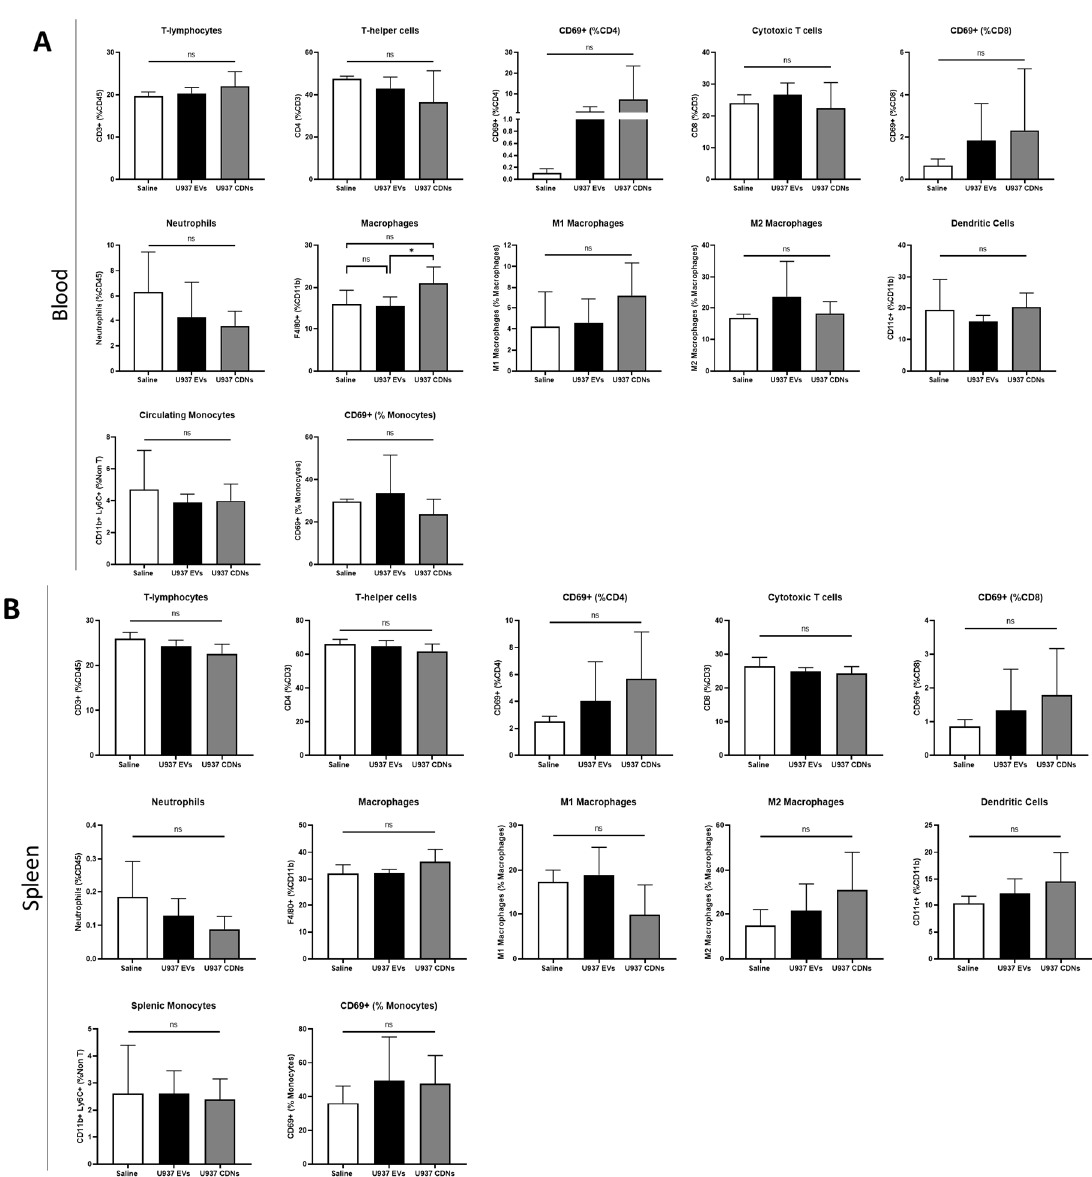
Figure 6. Immune cell profiles of ( A ) blood and ( B ) spleen after intravenous administration of saline, U937 EVs or U937 CDNs. Data presented as mean ± SEM ( n = 4 for saline, n = 5 for U937 EVs and CDNs). ns indicates no statistical difference, * indicates p < 0.05.